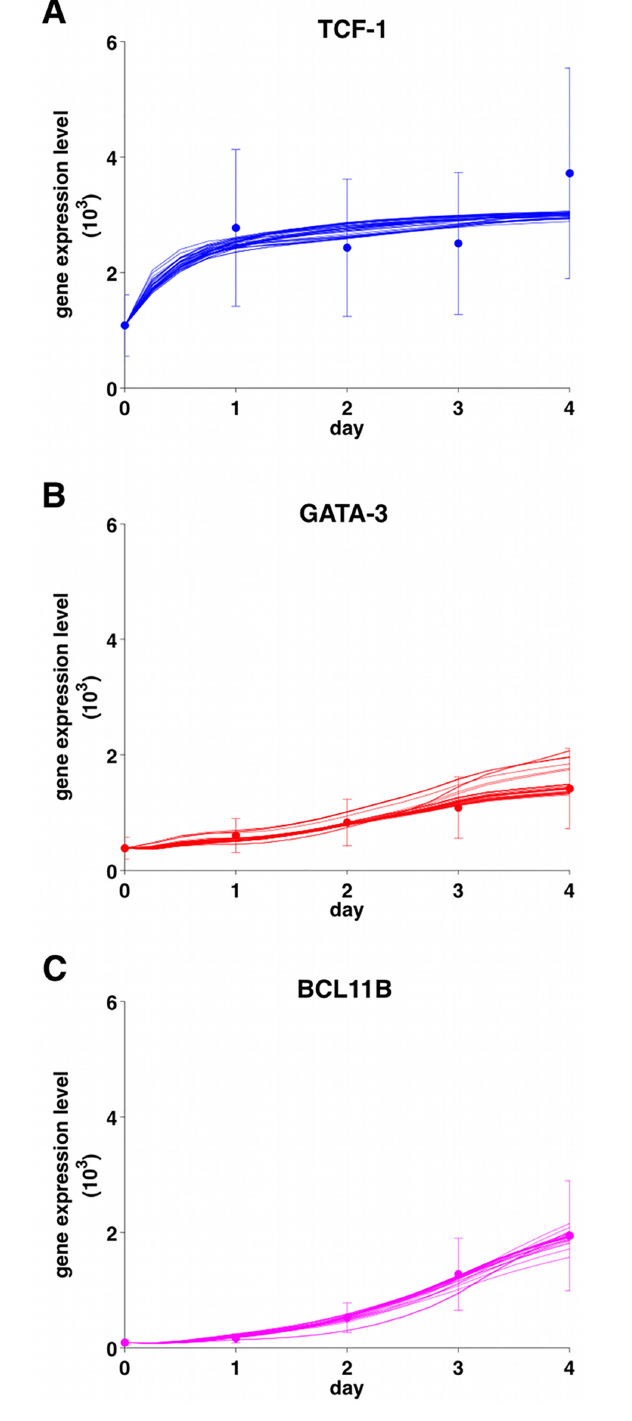
Fig 3. Model predictions. Realizations for the n parameter sets for the PU.1 dynamics (see text) of the winning model 6d, i.e . dimer TCF-1 AND (Notch OR dimer GATA-3) : predictions for TCF-1 (panel A), GATA-3 (panel B), and BCL11B (panel C). Dots: data points (adapted from [17] according to our conversion stage to time); bars: 95% intervals of confidence. The errors were estimated (CV percentages) from for each population from the log values of relative expression